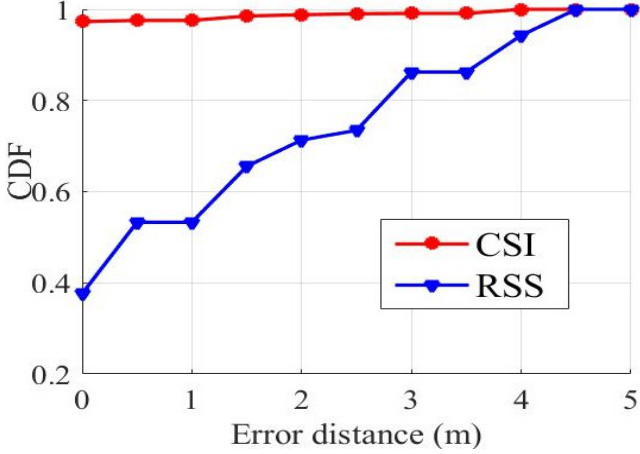
Figure 6. Localization precision of different sources of